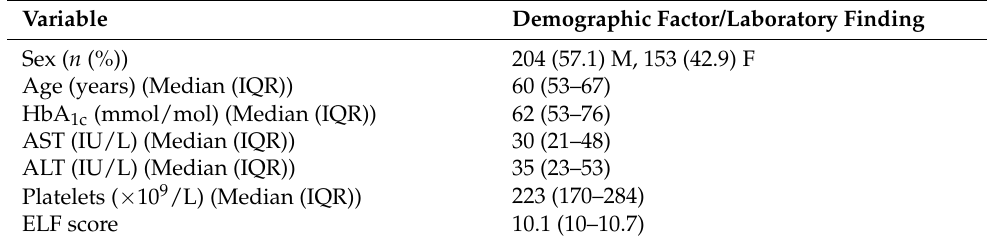
Table 1. Baseline data from the cohort ( n = 357).